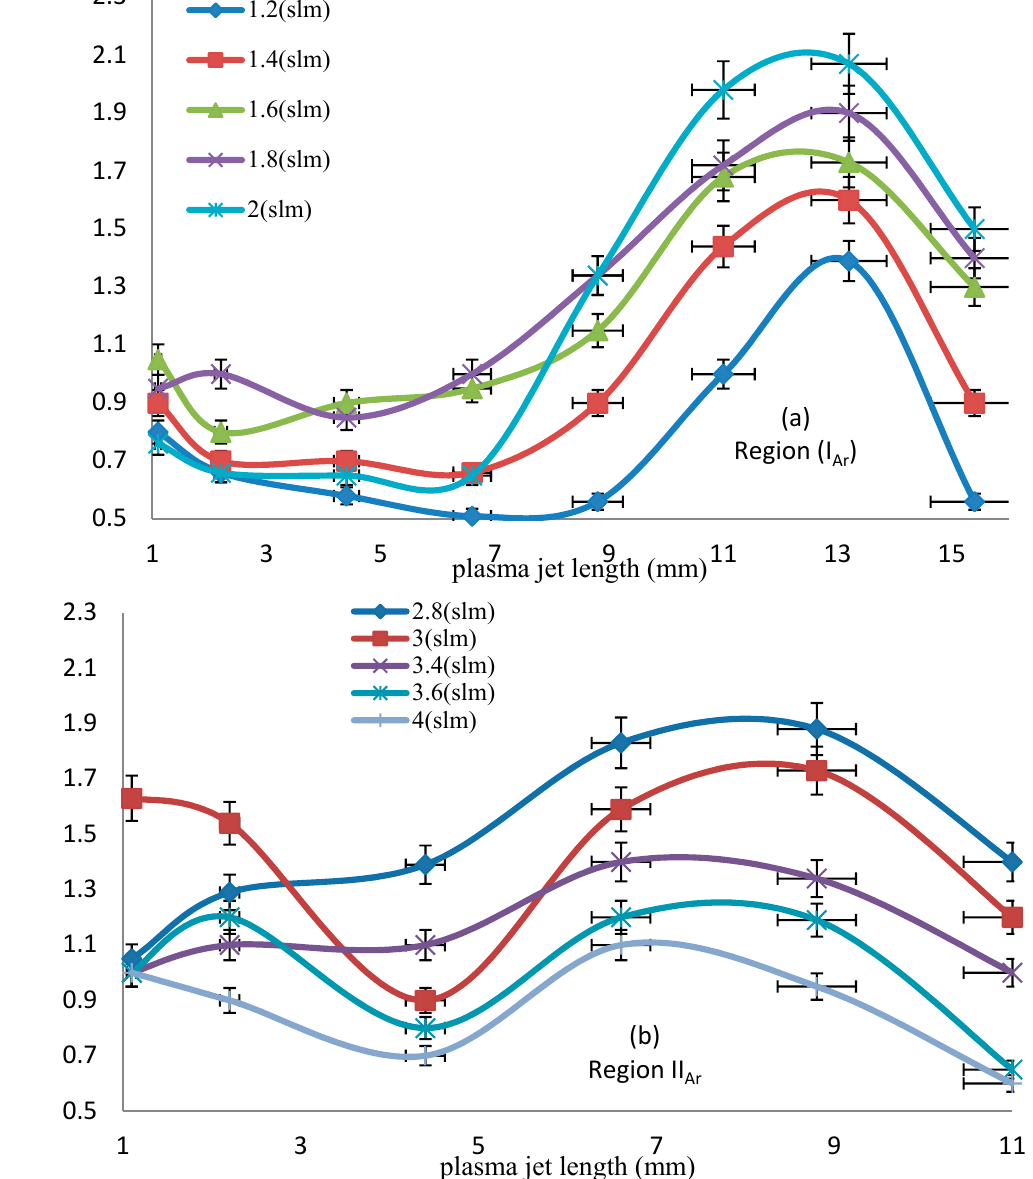
Figure 6. Relation between the plasma jet length and the width of the jet of dry argon for a flow rate ( a ) from 1.2 to 2 slm, ( b ) from 2.8 to 4 slm.